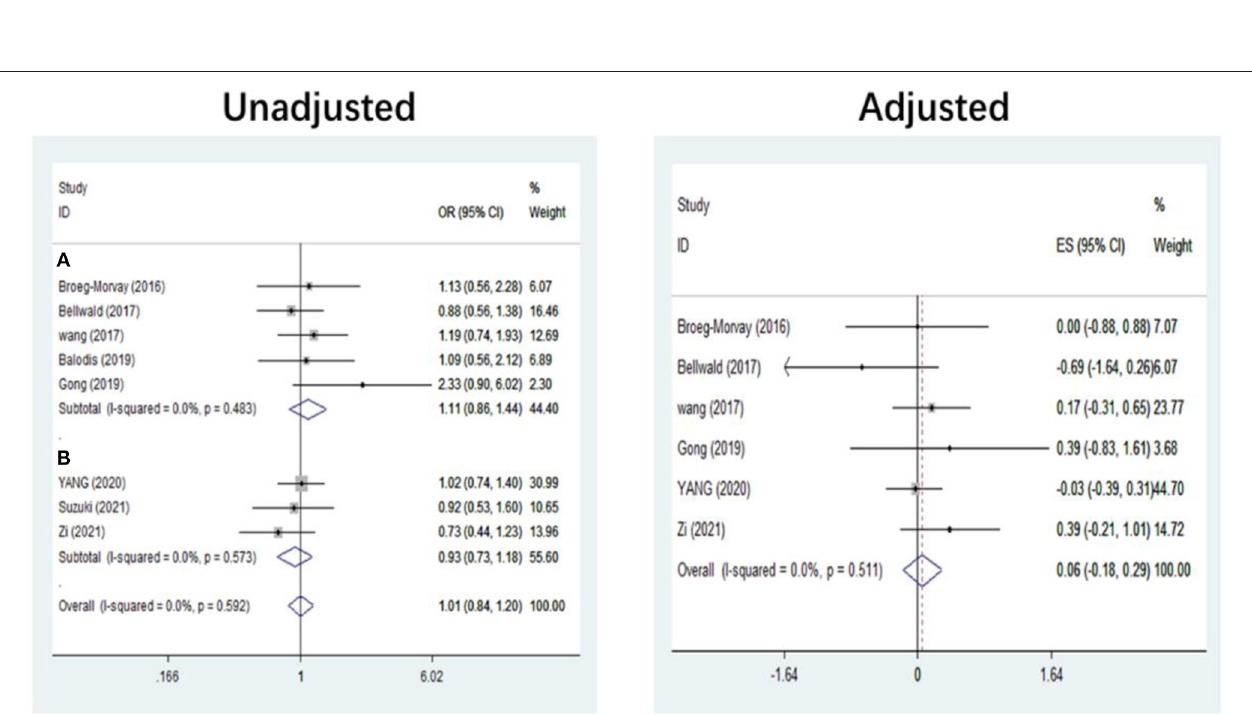
FIGURE 3 | Functional independence at 90 days. (A) Non-RCT. (B) RCT. RCT , randomized controlled trial; ES , effect size.